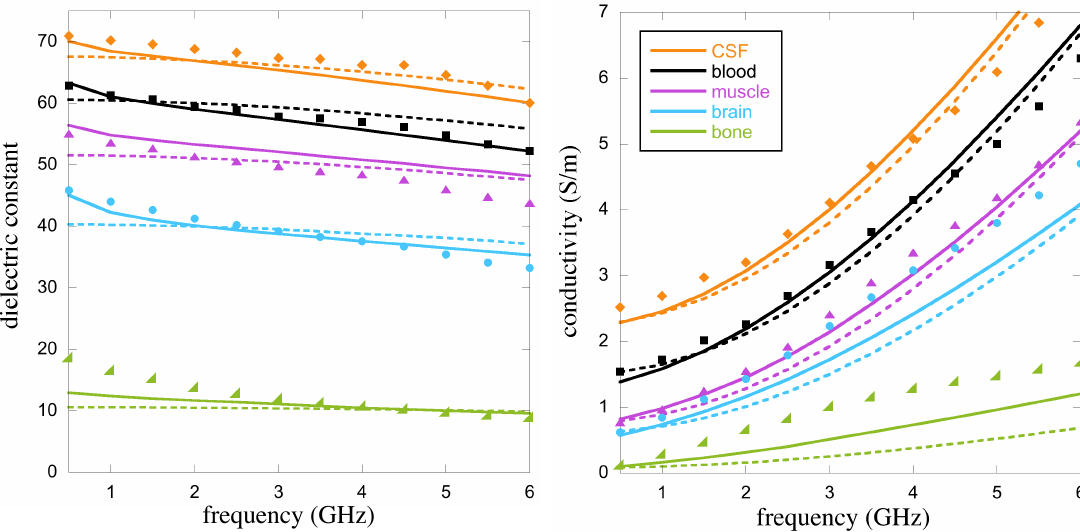
Figure 4. Means of the dielectric properties of various TMMs measured with three different set-ups (markers), compared to the results obtained by means of the tissue Cole–Cole models (full lines) and to those obtained with Böttcher’s binary mixture law (dashed